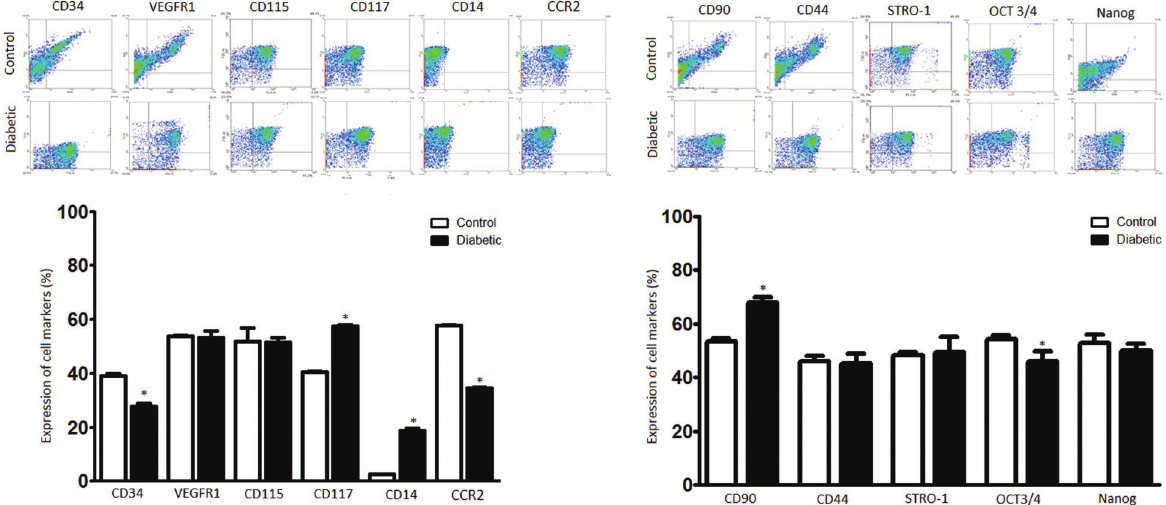
Figure 1. Representative fl ow cytometry plots of VYS cells from the control and diabetic groups. These were stained with markers for hematopoiesis (CD34, VEGFR1, CD117), monocytes/macrophages (CD115, CD14, CCR2), stromal tissue (CD90, CD44), and pluripotency (STRO-1, OCT3/4, Nanog). The expression of CD34, CCR2, and OCT3/4 was signi fi cantly reduced in the diabetic group. The histograms show the increased expression of CD90, CD117 and CD14 in the diabetic group compared with the control. Results are reported as the means ± SE of cells collected from fi ve yolk sacs per animal of the control (n=5) and diabetic groups (n=5) analyzed in duplicate. *P o 0.05 (ANOVA and Tukey's multiple comparison